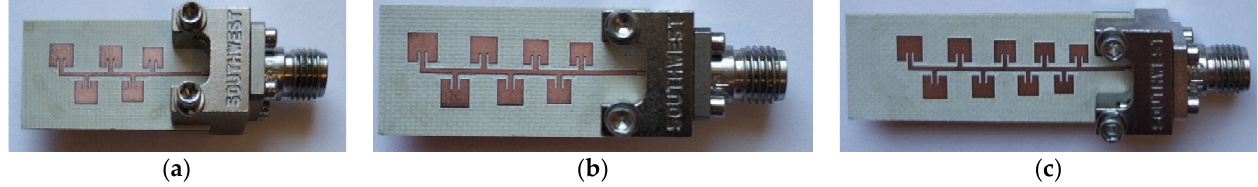
Figure 4. Fabricated prototypes of the log-periodic microstrip arrays: ( a ) 5 elements, ( b ) 7 elements, and ( c ) 9 elements.